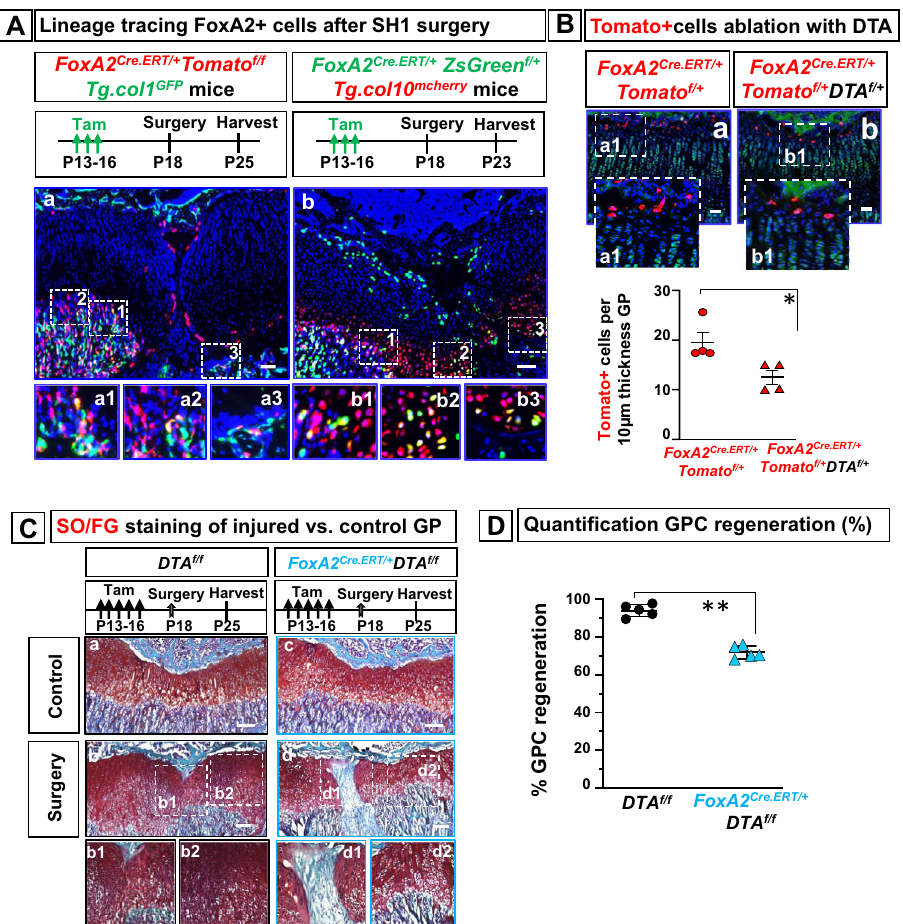
Fig. 8 Ablation of FoxA2 + cells impairs cartilage regeneration. A Tibia sections from FoxA2 CreERT/ + ; Tomato fl / + ; Tg.col1 GFP mice treated with tamoxifen (Tam) P13-P16, operated via Salter – Harris type 1 (SH1)-like surgery at P18, harvested at 7 days post-op ( a ). Representative details from the metaphyseal bone in numbered insets ( a1 – 3 ). Tibia sections from FoxA2 Cre.ERT/ + ; ZsGreen f/ + ;Tg.col10 mcherry mice treated with tamoxifen P13-P16, operated via SH1-like surgery at P18, and harvested 5 days post-op ( b ). Representative details from the hypertrophic zone in numbered insets ( b1 - 3 ). Scale bars are 100 µ m. B Tibia sections harvested from FoxA2 CreERT/ + ;Tomato fl / + ( a ) and FoxA2 CreERT/ + ;DTA f/ + ;Tomato fl / + ( b ) mice treated with tamoxifen P13-P16, harvested at P18. Hoechst dye (blue), 5-DTAF (green). Insets, magni fi ed view of the FoxA2 + cells visualized by Tomato fl uorescence microscopy (red) (a1, b1).